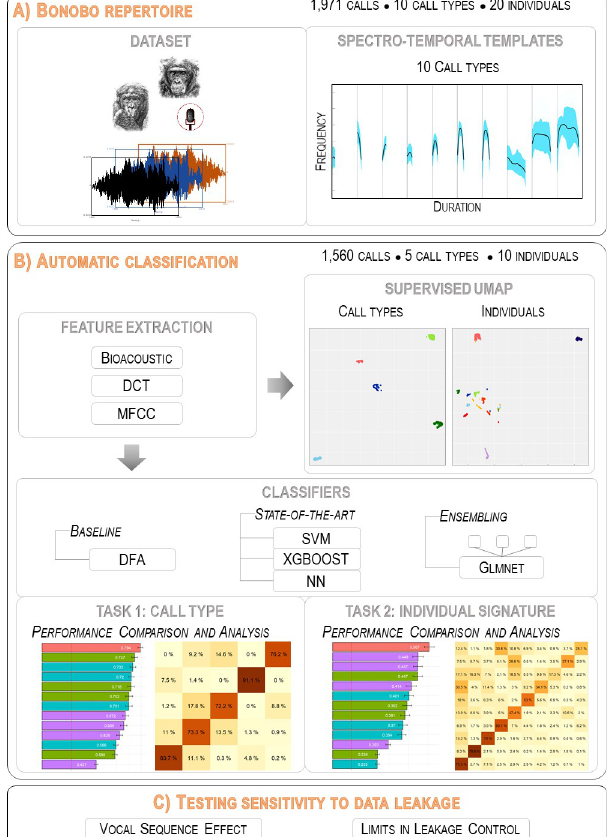
Fig 1. Workflow implemented to analyze a dataset of animal vocalizations. Block A is species-dependent and illustrates the bonobo case. The other blocks are generic over SUNG datasets. A. The traditional bioacoustic approach is applied to the bonobo dataset to deduce call type templates. B. Three different sets of acoustic features are associated (BIOACOUSTIC, DCT, and MFCC) to characterize the bonobo acoustic space. Supervised UMAP is run to visually assess call type and individual separability. The performance of three state-of-the-art classifiers and their ensembling combinations is assessed and compared to that of a discriminant analysis (DFA) in two tasks: identification of call types (bonobos have a vocal repertoire composed of different calls) and discrimination between emitters (identification of individual vocal signatures). C. The sensitivity of accuracy to the composition of the training and test sets and to the induced data leakage is then